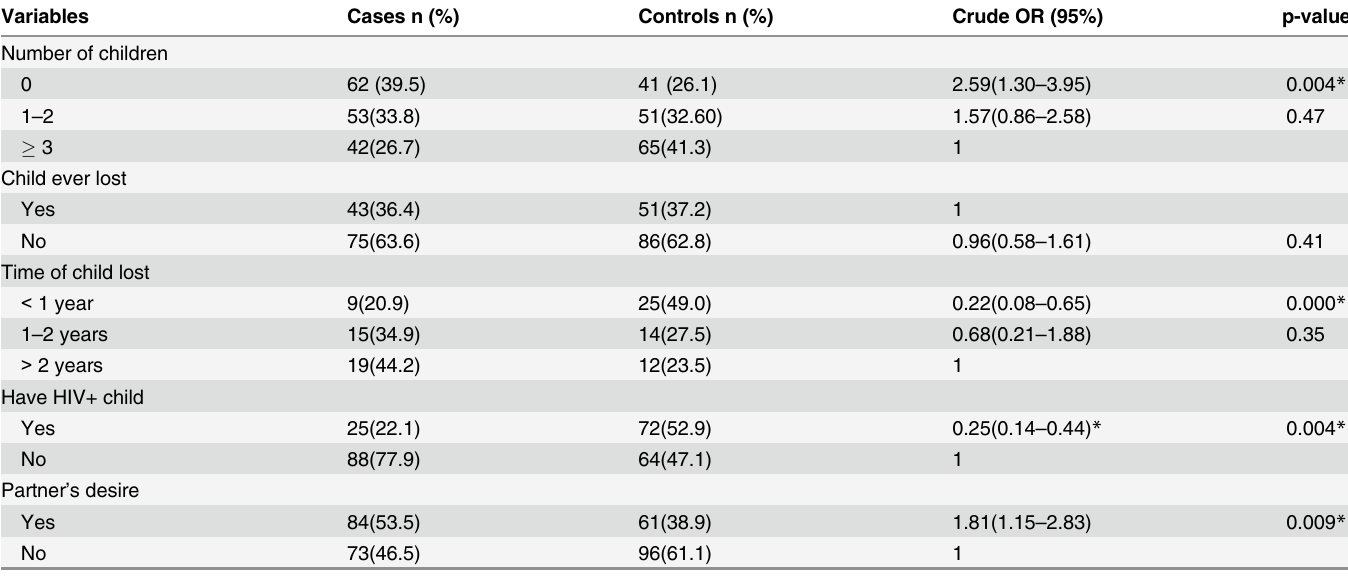
Table 2. Reproductive histories of cases and controls included in the study, Afar, Ethiopia,